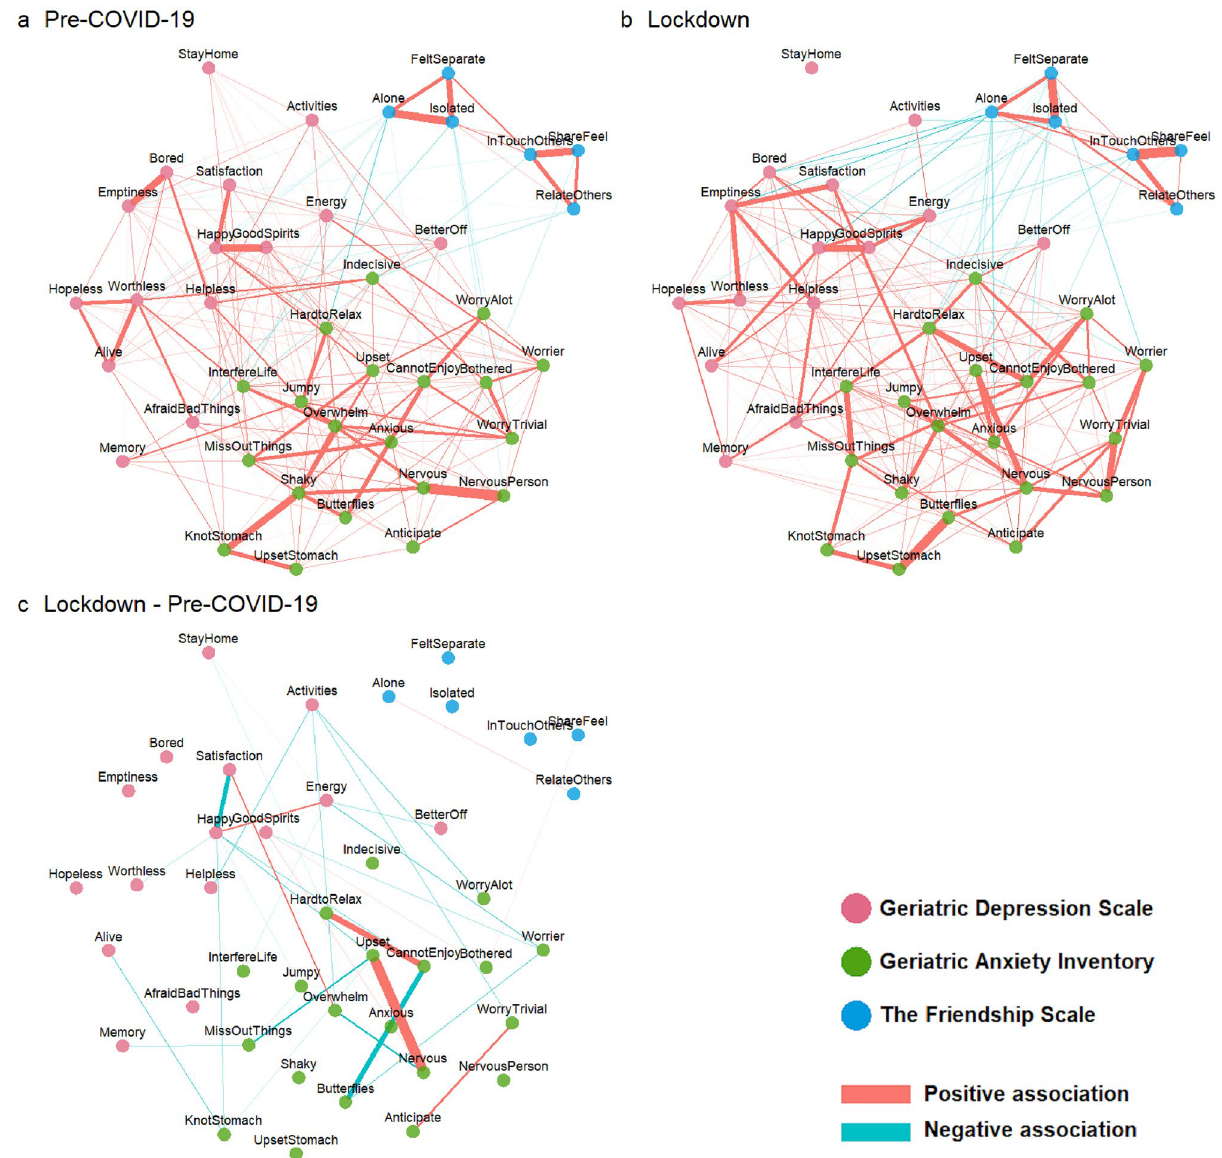
Figure 2. Partial correlation networks depicting items from the geriatric depression scale, geriatric anxiety inventory and the friendship scale at ( a ) Pre-COVID-19 and ( b ) lockdown. Differences across time in edges values are presented in the ( c ) Lockdown—Pre-COVID-19 network. Only the edges with significant changes (uncorrected p > 0.05) across time, as determined by the paired network comparison test, are shown. “Positive association” and “Negative association” in the context of ( c ) meant that the edges became more positive or negative, respectively, across time. Thicker lines corresponded to stronger